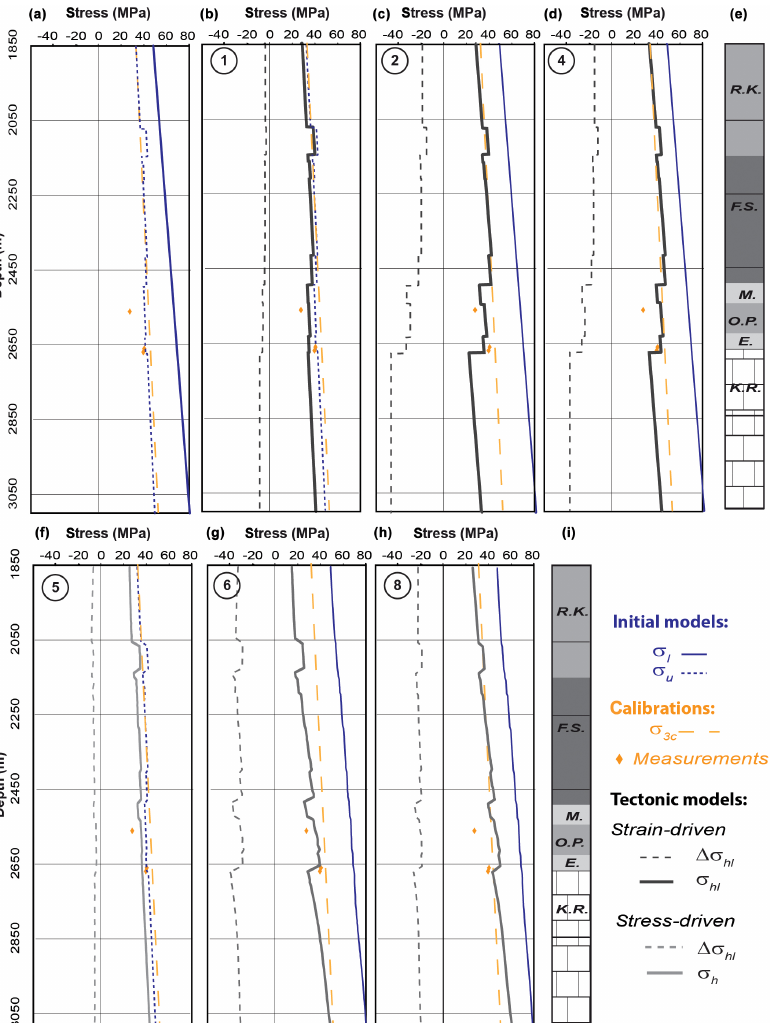
Figure 5. Calculated stresses for the various models and predictive strategies. (a) Uniaxial ( σ u ) , lithostatic ( σ l ) , and critical ( σ 3c ) models. (b–g) Stress predictions for the various predictive strategies, including the local stress corrections (cid:49)σ hl and the predicted minimum principal stress σ hl . Circled numbers are labels of the predictive strategies as presented in Table 1. The relevant initial stress (i.e., uniaxial σ u or lithostatic σ l ) and calibration stresses (i.e., in situ stress measurements and the critical stress σ 3c ) are also represented for each predictive strategy. The diamonds represent the average values of the minimum principal stress (set equal to the instantaneous shut-in pressure values). (e) and (i) Show simplified stratigraphic column of the studied area with the same legend as for Fig. 4. Cases 3 and 7 in Table 2 are not represented because the tectonic effects are negligible, and therefore the predicted minimum principal stress σ hl is equal to the calibration stress, σ u . The Muskwa (M.), Otter Park (O.P.) and Evie (E.) members together form the Horn River Formation, surrounded by the Keg